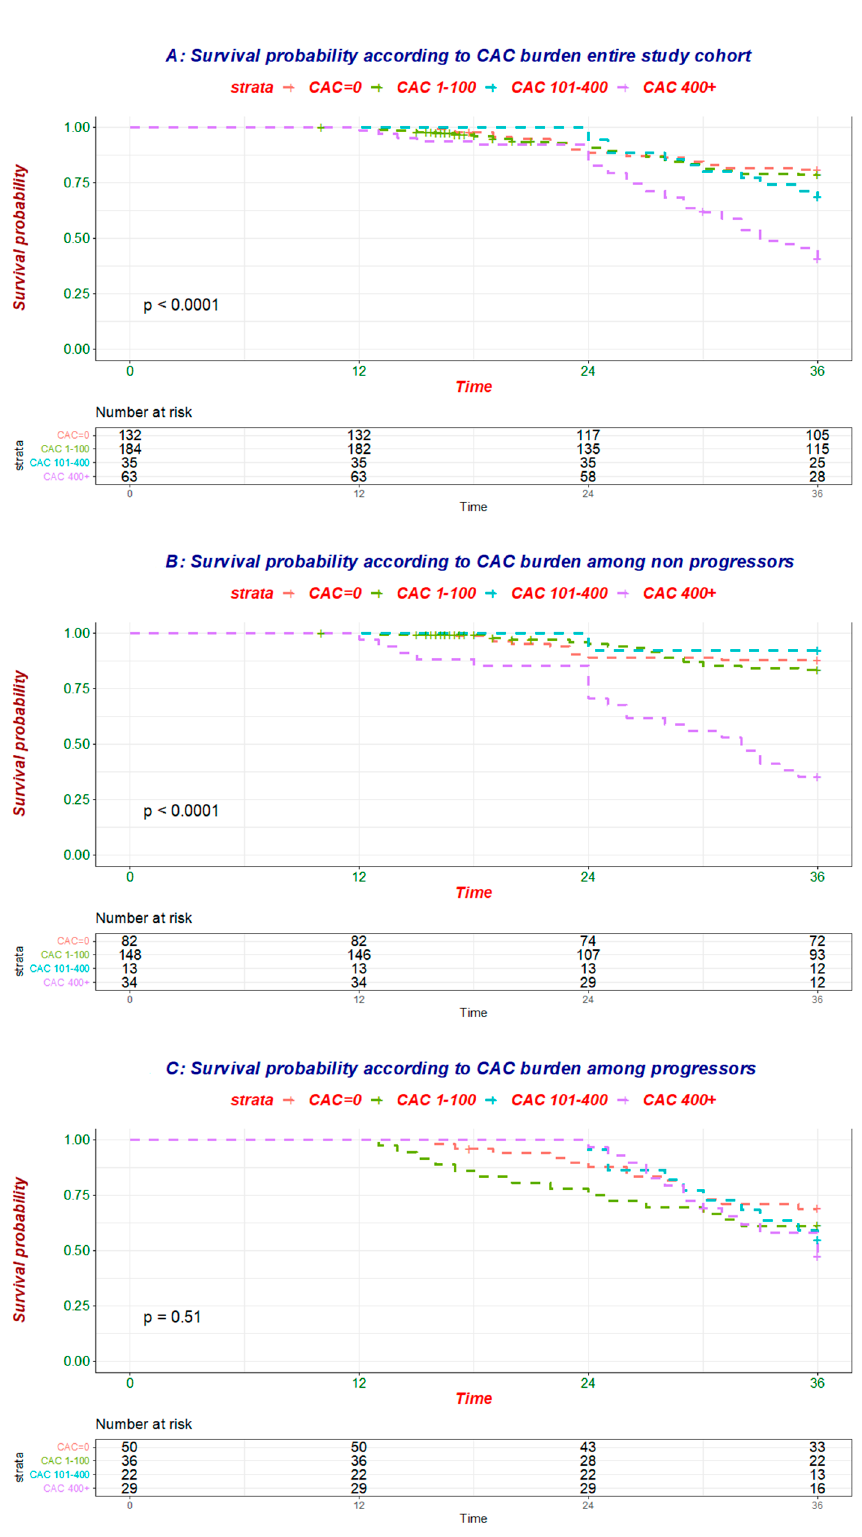
Figure 2. Survival probability according to baseline coronary artery calcification (CAC) in the entire study cohort ( A ) as well as patients without ( B ) and with ( C ) evidence of CAC progression during the first 12 months of